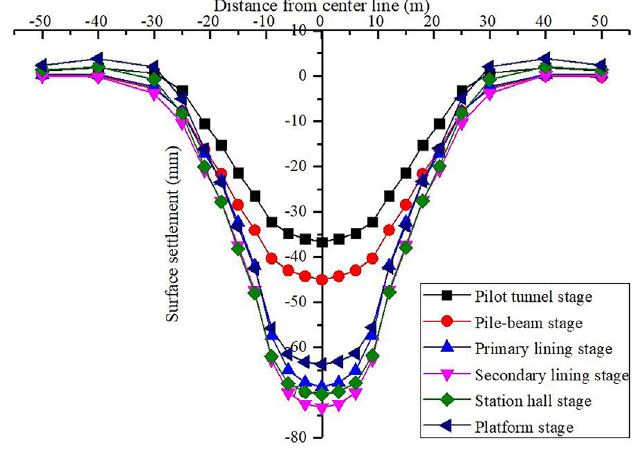
Figure 11. The curve of ground settlement in each stage of station Construction.